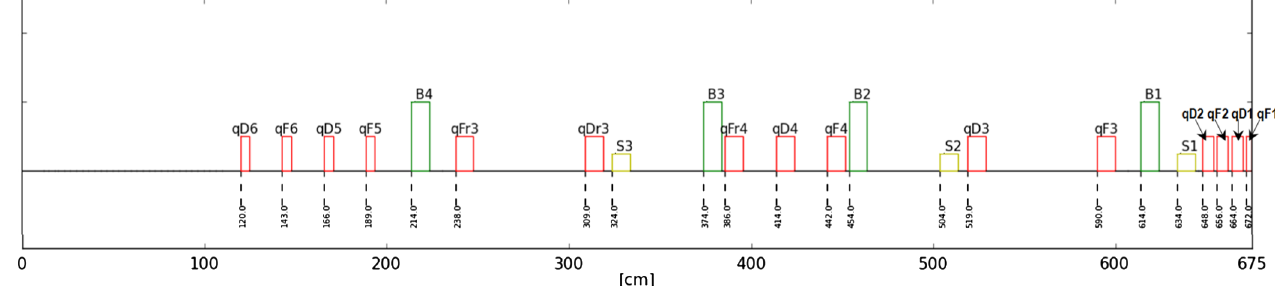
FIG. 4. The lattice configuration of the positive R 56 compressor. The green columns indicate the four dipole magnets, the red columns indicate the quadrupole magnets, and the yellow ones indicate the sextupole magnets. The 0 point corresponds to the starting point of the photocathode rf gun.